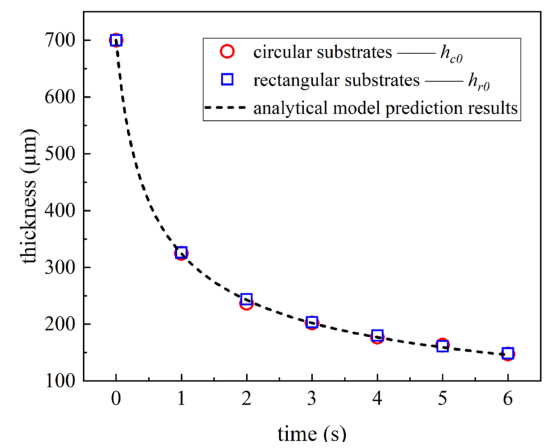
Figure 4. Comparison of results of numerical simulation and analytical model. (* h c0 : average film thickness of the central region on the circular substrate in the simulation. * h r0 : average film thickness of the central region on the rectangular substrate in the